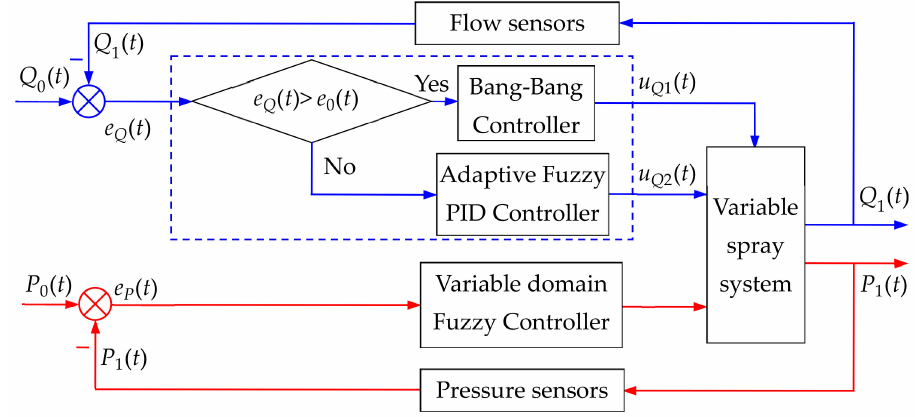
Figure 2. Diagram of variable spray in the control structure on double